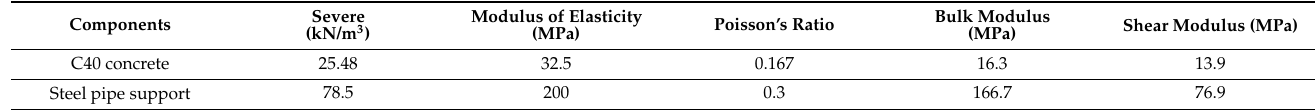
Table 5. Material parameters of concrete and